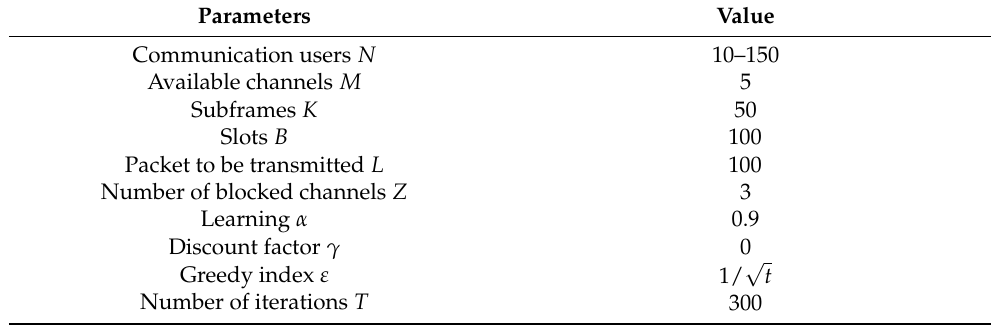
Table 1. Settings of Model related parameter.